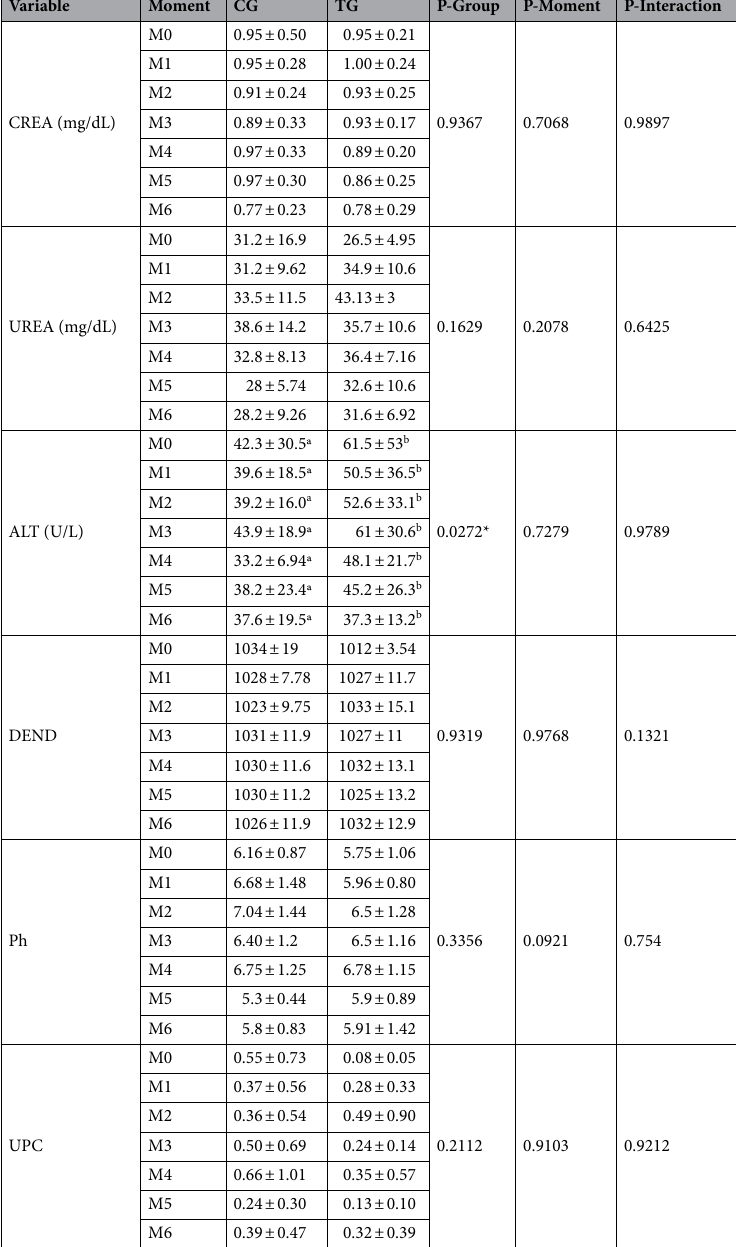
Table 5. Mean ± SD of serum and urinary biochemistry findings in bitches with mammary carcinoma treated (TG) or not treated (CG) with 4.4 mg/kg/day of carprofen for 90 days and evaluated for 6 months. CREA: creatinine; URA: urea; ALT: alanine aminotransferase; DEND: urine density; Ph: potential of hydrogen; UPC: urine protein/creatinine ratio. a and b indicates difference